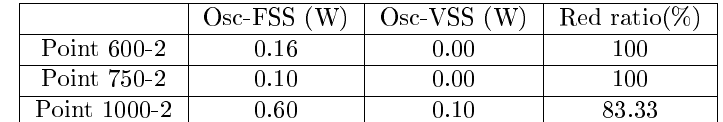
Table 3. Steady state oscillation